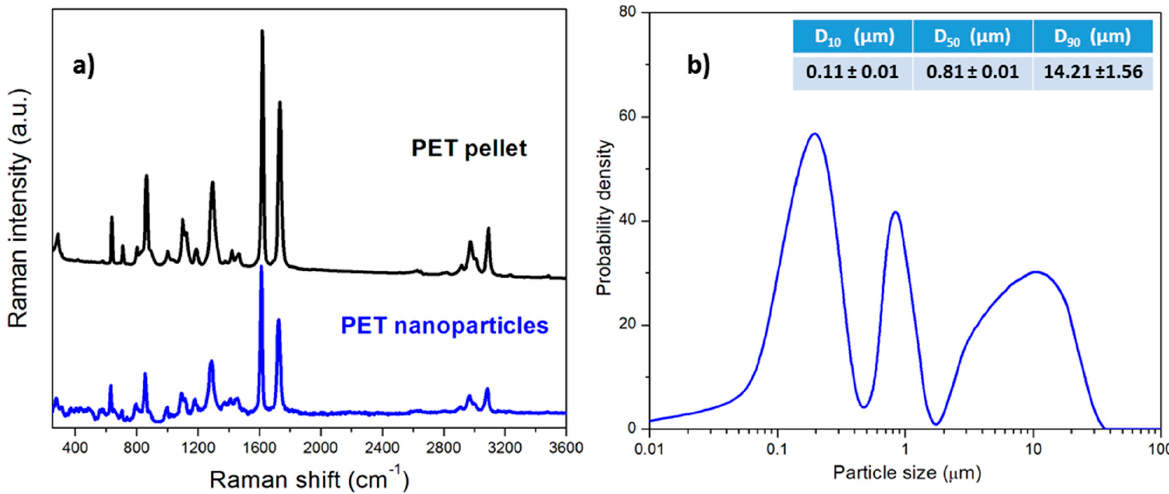
Figure 1. ( a ) Raman spectra of label-free PET nanoplastics and PET pellet; ( b ) particle size distribution of the aqueous dispersion of label-free PET nanoplastics.